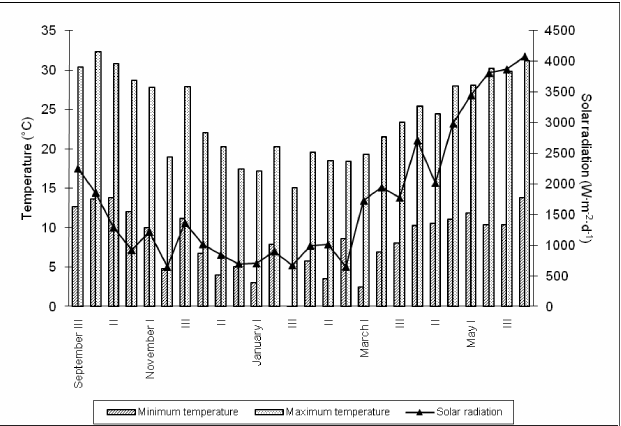
Fig. 1 - Trend of temperature and solar radiation. Fondi (Latina), 2003-